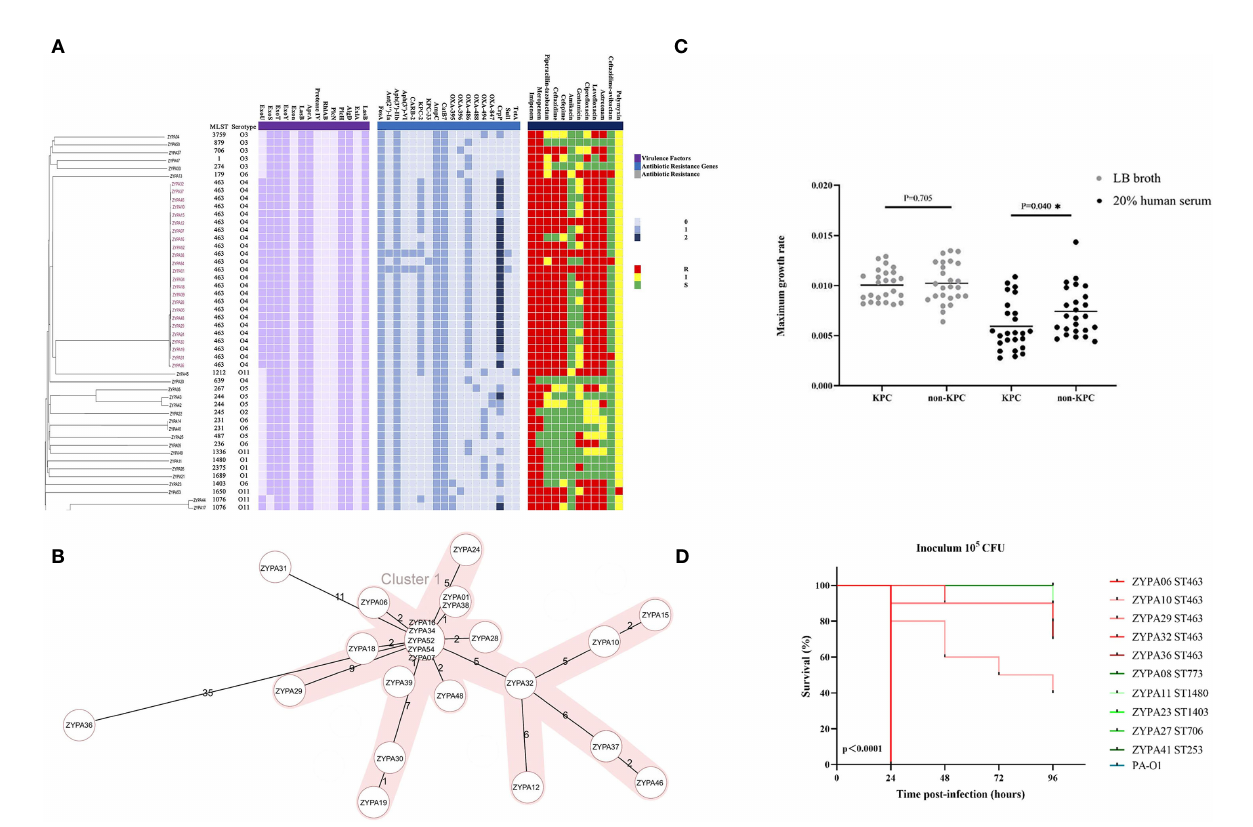
FIGURE 3 | (A) Genetic relatedness, antibiotic resistance genes, virulence factor determinants, and antimicrobial susceptibility testing results of 50 CRPA BSI strains. These features are shown separately on the four blocks of the picture. The gray value indicates the copy number of the antibiotic resistance gene and virulence factors bla KPC-2 and ST463 are highly associated (22 out of 24; 91.7%). R, resistant; I, Intermediate; S, Sensitive; (B) Minimum spanning trees of 24 ST463 CRPA BSI strains from cgMLST analysis. Distance based on 4823 targets genes with pairwise ignore missing values. CgMLST pro fi les are represented by circles. The shaded parts represent the same cluster with a distance threshold of 10. The size of the circle is proportional to the number of isolates sharing the same cgMLST pro fi le, with the biggest one including fi ve isolates; (C) Neutrophil-killing resistance; at the maximum growth rate of KPC and non-KPC group; (D) Virulence potential in a G mellonella infection model. Five isolates of ST463 and fi ve isolates of other STs representing various genetic background were randomly selected for the infection assay at 10 5 CFU. P values were calculated by log-rank (Mantel-Cox) test. Each line represents a single isolate. Isolate PA-O1 was used as the control. Abbreviation: CFU, colony-forming units.